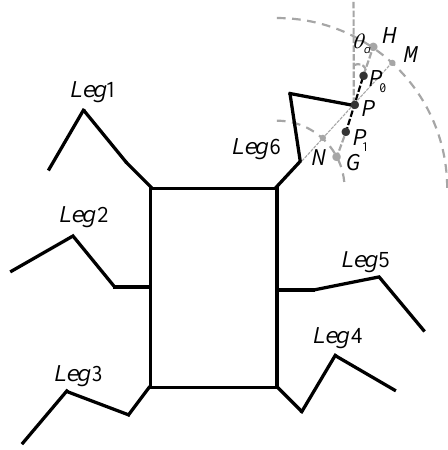
Figure 10. Start and end points selection geometric